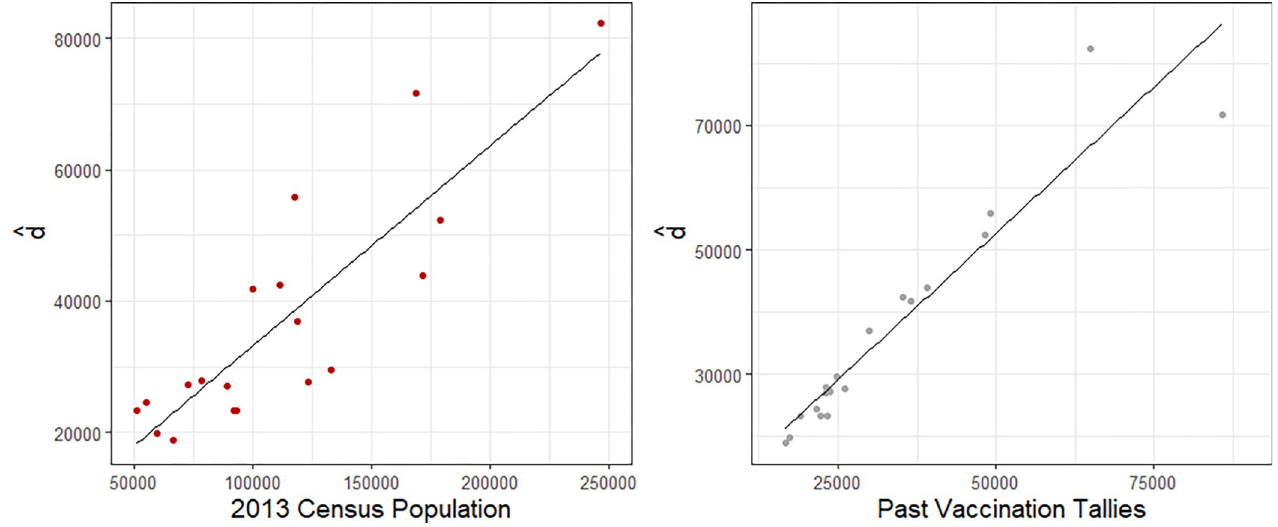
Fig 1. Census data (2013) & past vaccination tallies from Child Health Day 6-months earlier vs estimated denominators.